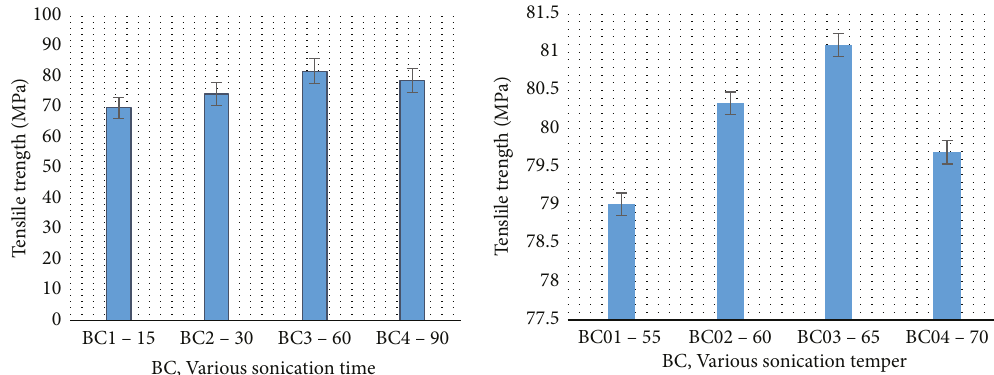
Figure 11: Tensile strength of BC films when isolated under different